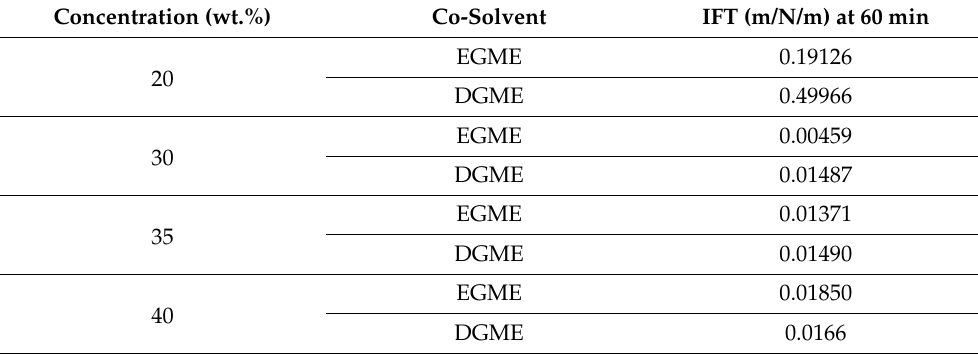
Figure 5. Interfacial tension (IFT) results for surfactant with 20 to 40 wt.% of co-solvent addition diluted in seawater at 0.1 wt.% concentration. Table 4. IFT values at 60 min with different concentrations of co-solvent in the surfactant–co-solvent mixture.